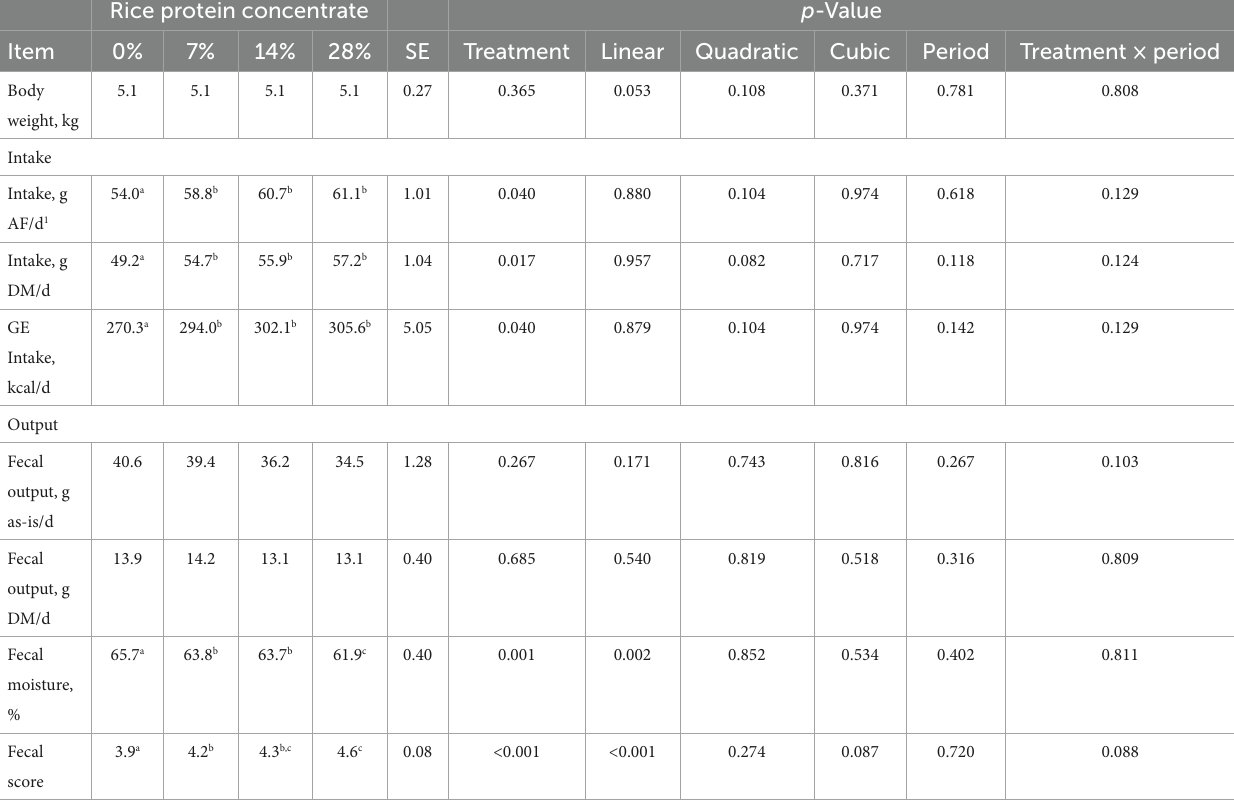
TABLE 4 Mean intake, fecal output, and fecal scores of cats consuming increasing levels of rice protein concentrate. Rice protein concentrate